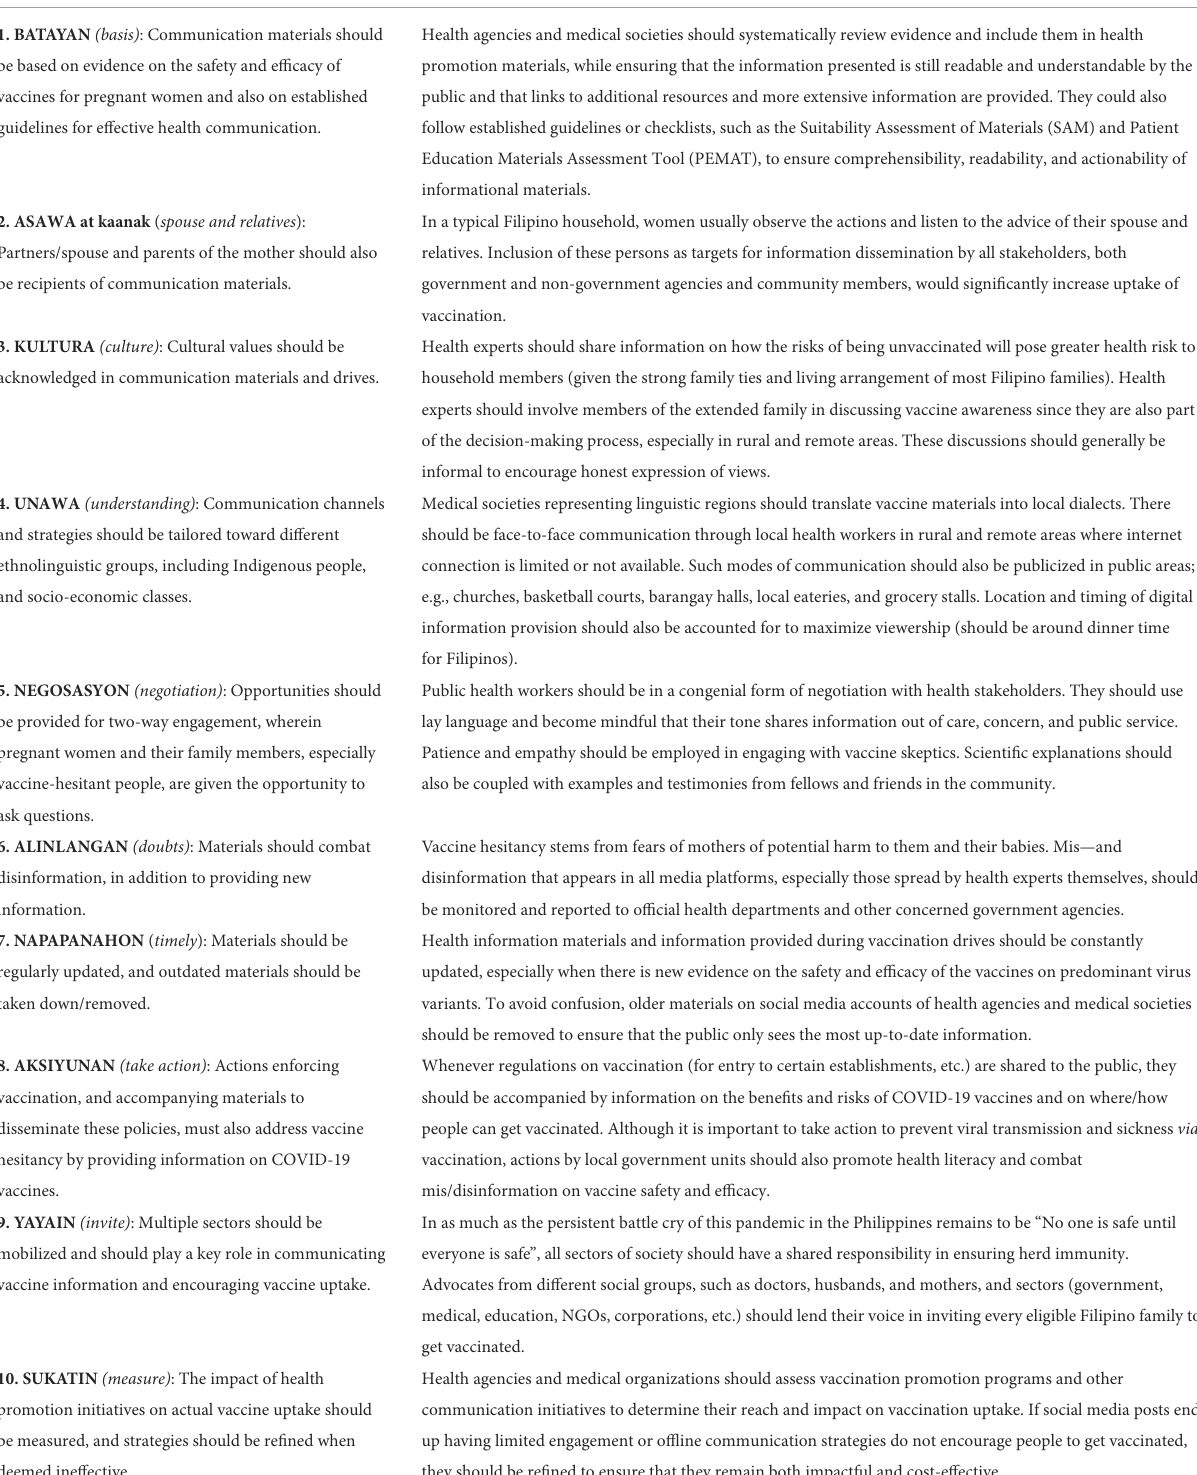
TABLE 1 BAKUNANAYS guidelines for communicating COVID-19 information to pregnant women in the Philippines and in countries with similar socio-demographic profiles and cultural values.